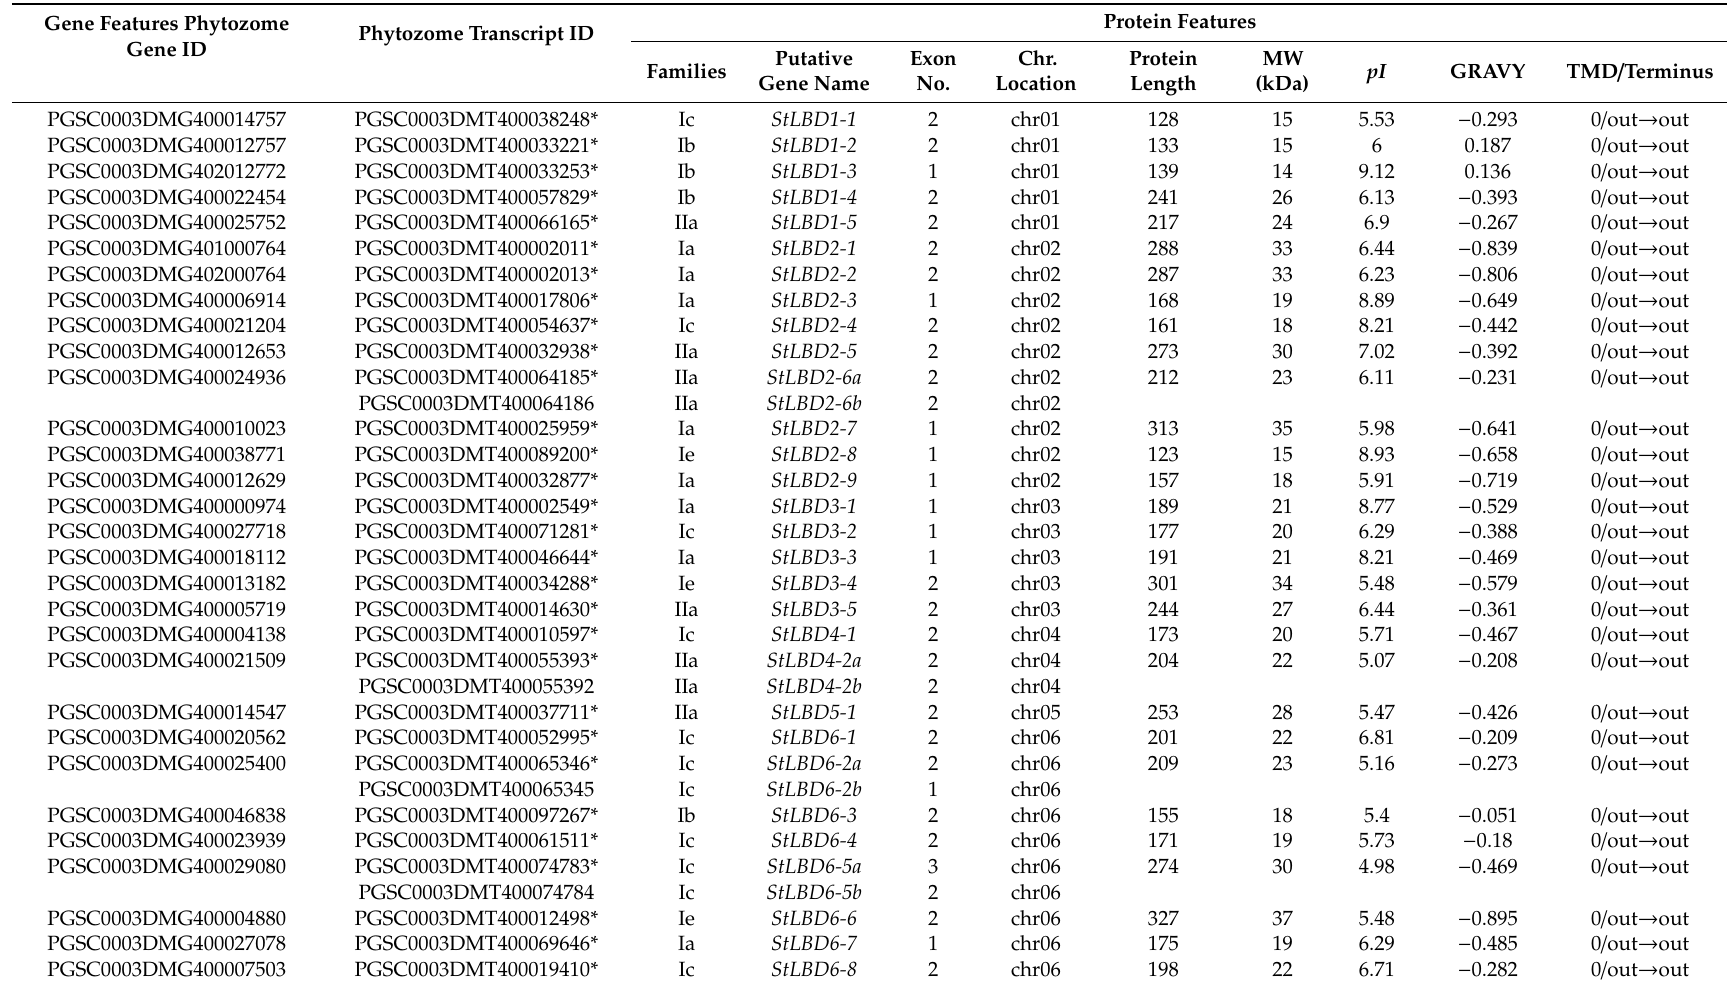
Table 1. Information on the lateral organ boundaries domain ( LBD ) transcription factor family in Solanum tuberosum